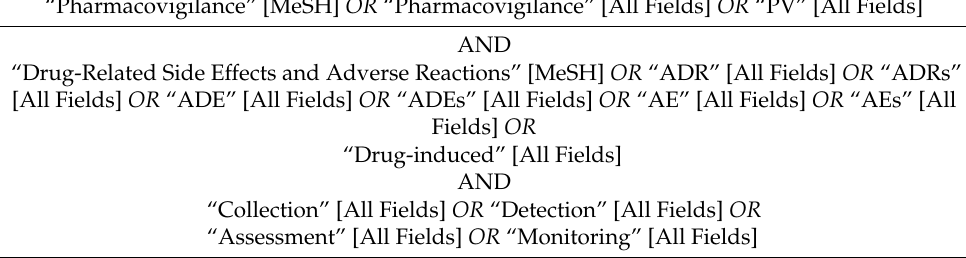
Table 1. Medical Subject Heading (MeSH) terms used in reviewing the published literature related to pharmacovigilance (if no “MeSH” term exists, search for “All